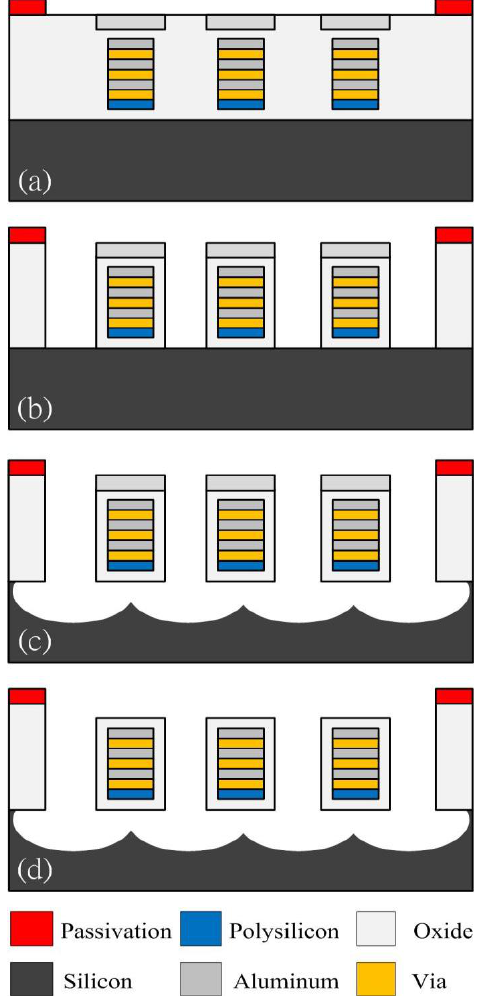
Figure 8. Fabrication flow of the magnetic sensor, ( a ) after the CMOS process; ( b ) removing the oxide layer; ( c ) etching the silicon substrate; ( d ) removing the aluminum hard